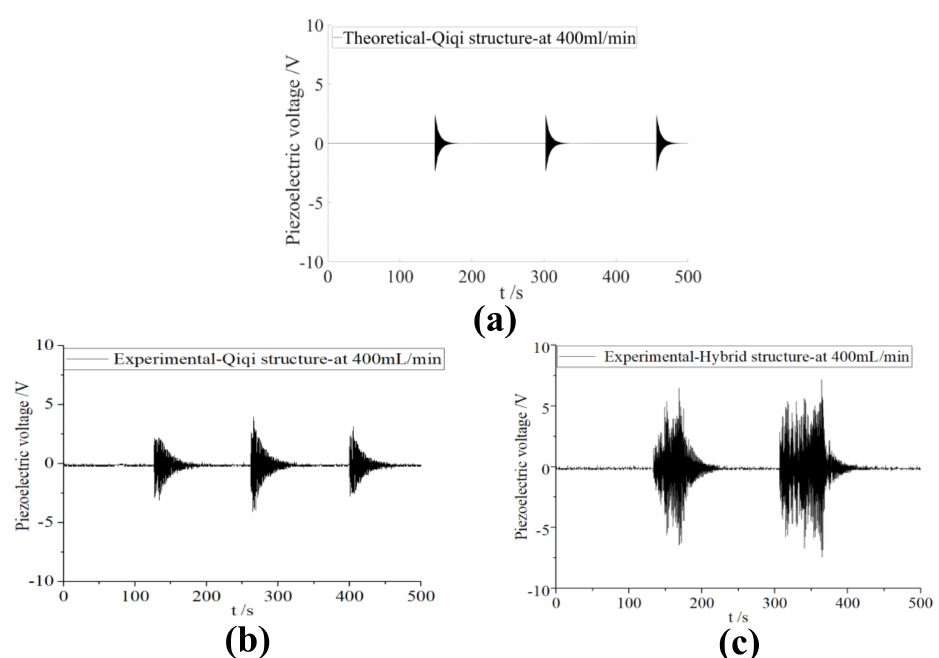
Figure 7. Performance comparison between the Qiqi structure and the proposed hybrid structure: ( a ) theoretical piezoelectric voltage of the Qiqi structure at 400 mL/min; ( b ) experimental piezoelectric voltage of the Qiqi structure at 400 mL/min; ( c ) experimental voltage of the proposed hybrid structure at 400 mL/min.